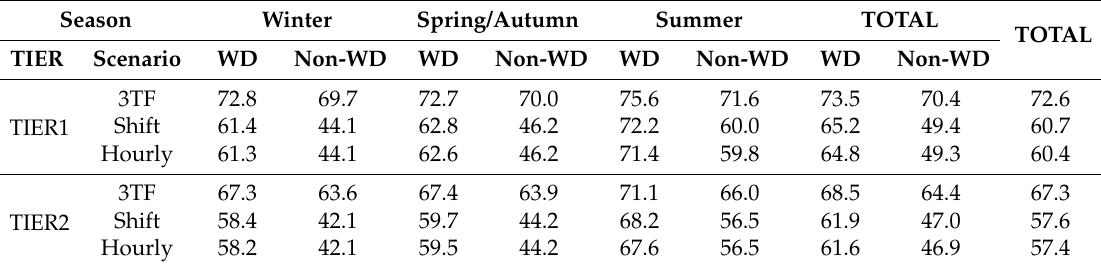
Figure 8. Monthly energy losses on Sec SS 3 with the three control systems of the number of transformers connected, considering that transformers fulfilled TIER2. Table 7. Percentage of losses with new transformers compared to the current connection